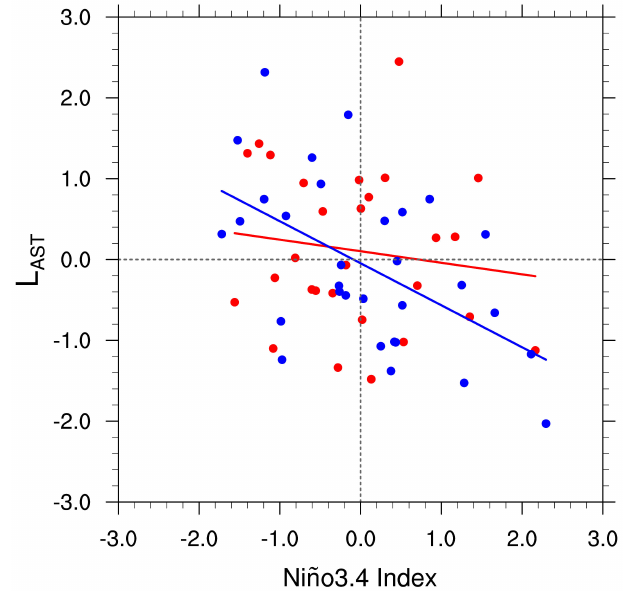
Figure 4. Scatterplot of the L AST as a function of the Niño3.4 index for positive (red dot) and negative (blue dot) AMO phases, together with the corresponding regression